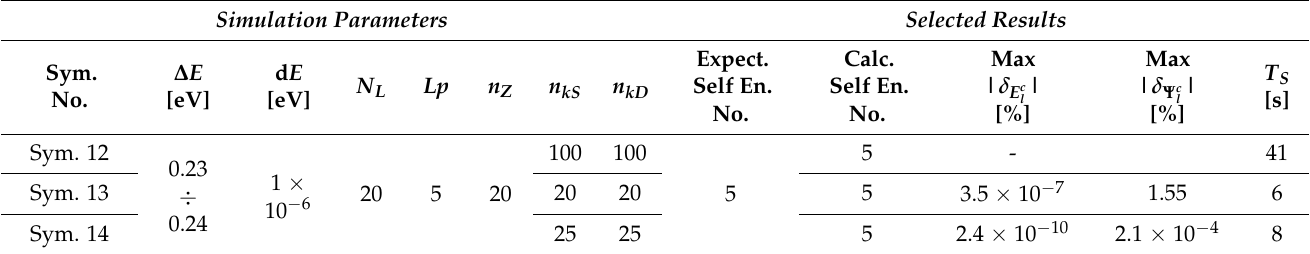
Table 6. Basic parameters and selected results of simulations for structure presented in [28]. Simulation